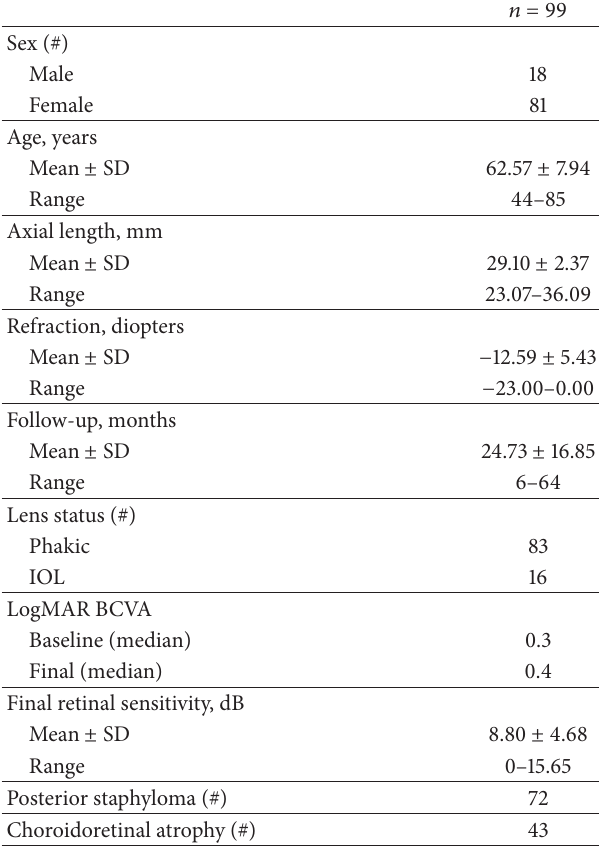
Table 1: Summary of subject demographic and clinical characteris-